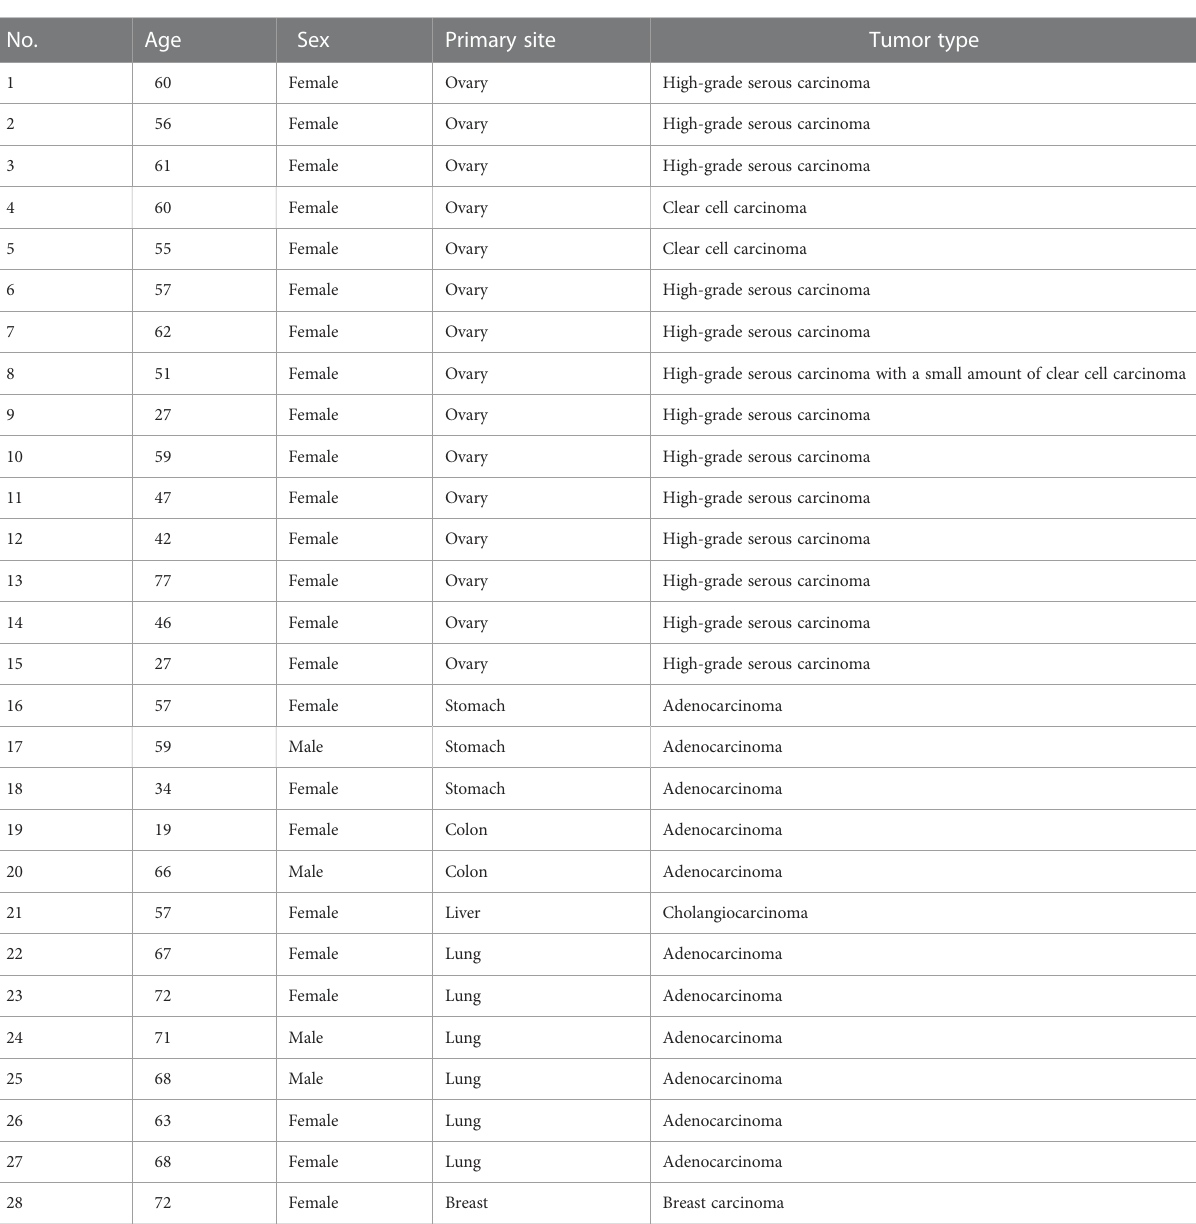
TABLE 1 Cases of malignant body cavity effusions.